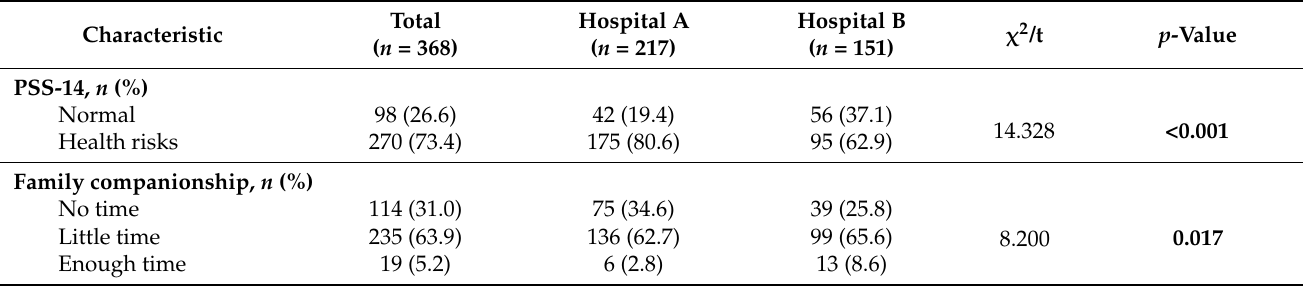
Table 2. Differences in health measurements between the two